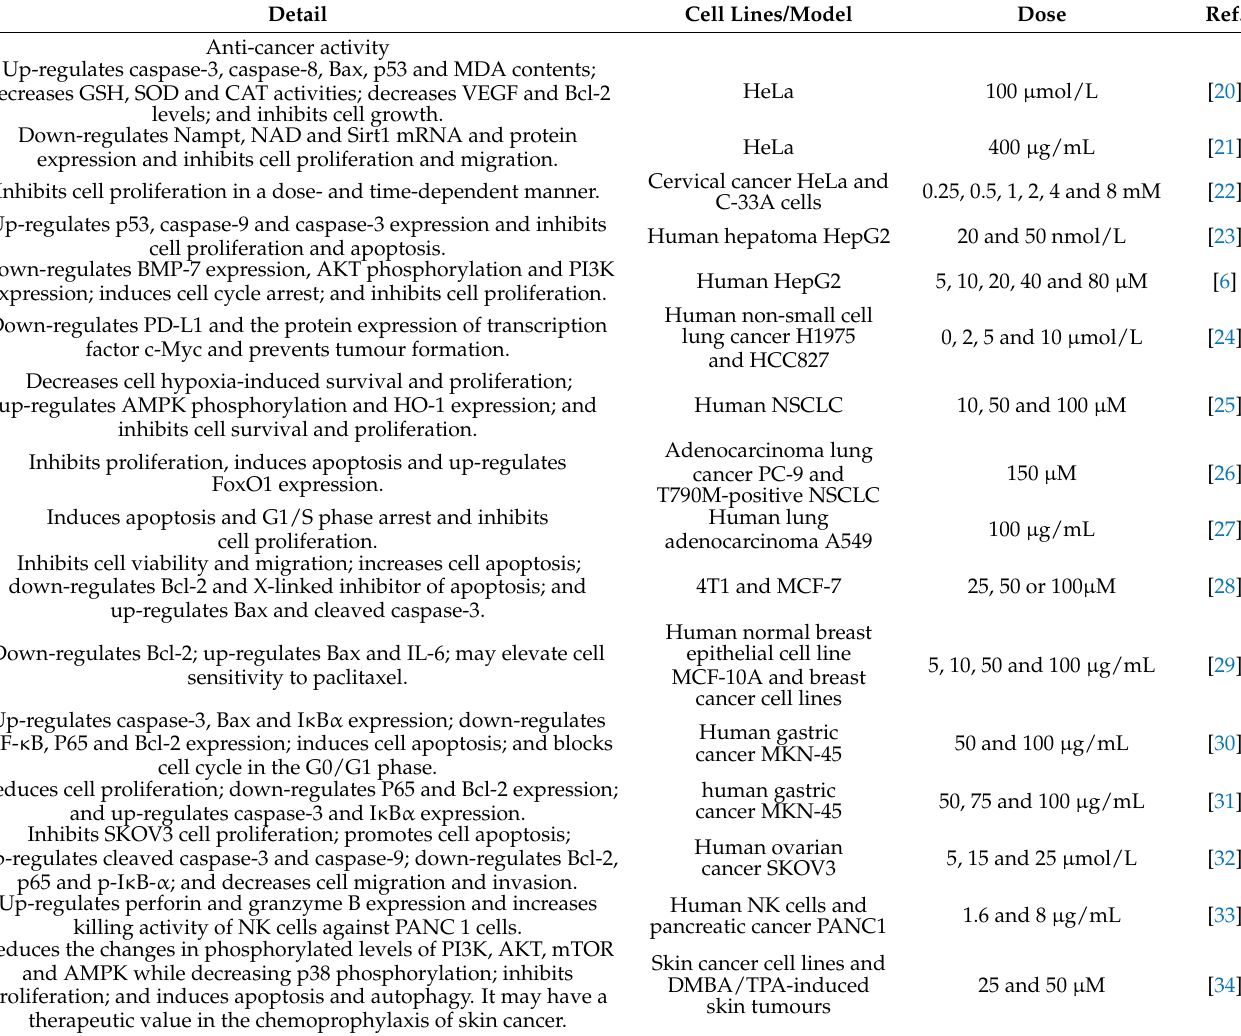
Table 1. Anti-cancer Activity of